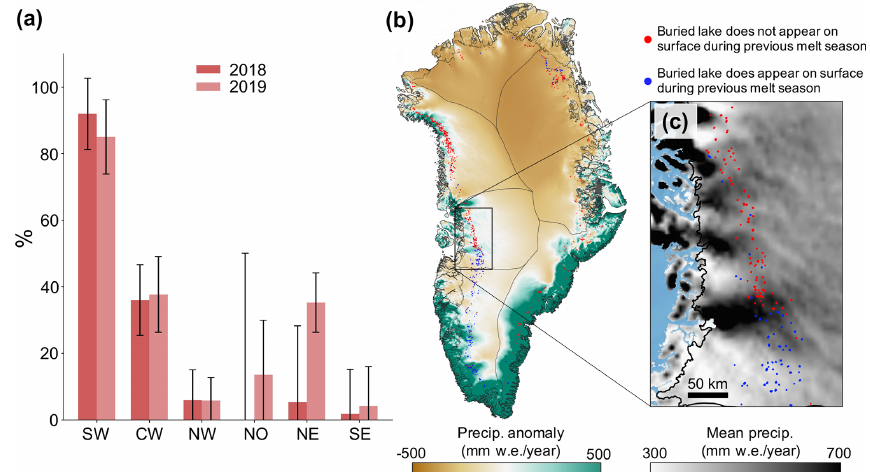
Figure 5. The impact of annual precipitation on buried lake formation processes. (a) Percentage of buried lakes that show any evidence of meltwater on the surface ( > 5 pixels with an NDWI > 0.25) during the previous melt season, for each of the six subregions. (b) Spatial anomaly of the climatological (1958–2017) mean annual precipitation. Red dots represent buried lakes from 2018 and 2019 that never appeared on the surface during the previous melt season. Blue dots represent detected buried lakes from 2018 and 2019 that appeared on the surface during the previous melt season. (c) Climatological mean annual precipitation with buried lakes plotted in CW